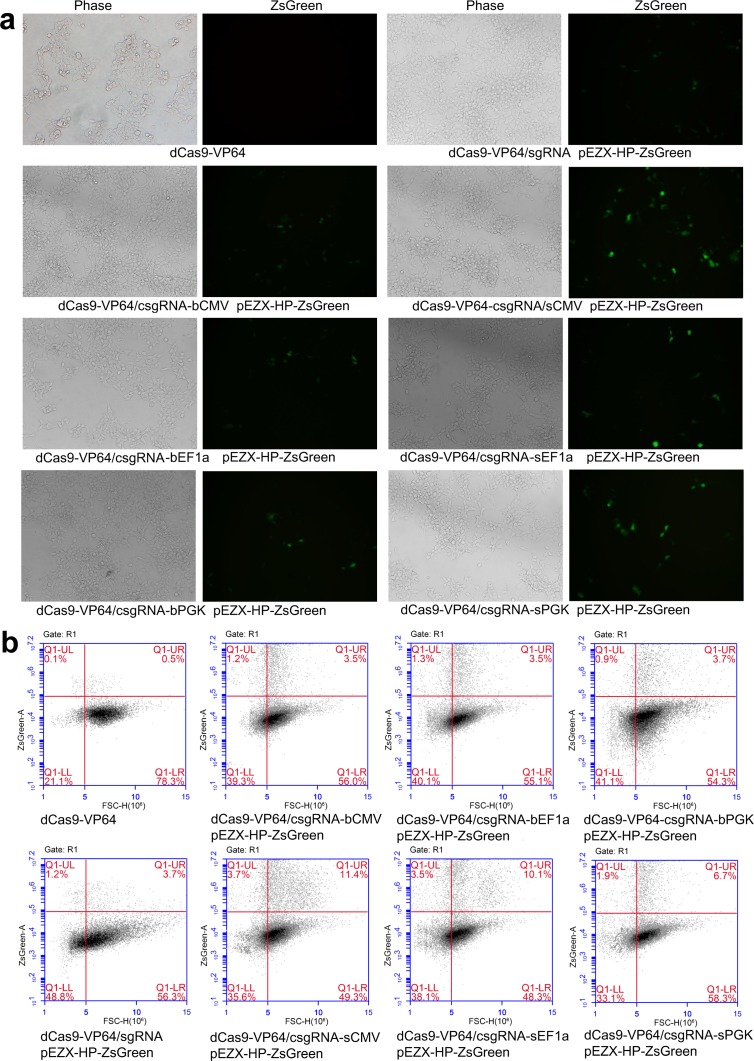
Activation of exogenous and endogenous genes with other CRISPR-assisted trans enhancers.(a) Activation of exogenous ZsGreen gene in 293 T cells with two new trans enhancers, sEF1a and sPGK. (b) Flow cytometry analysis of ZsGreen expression.